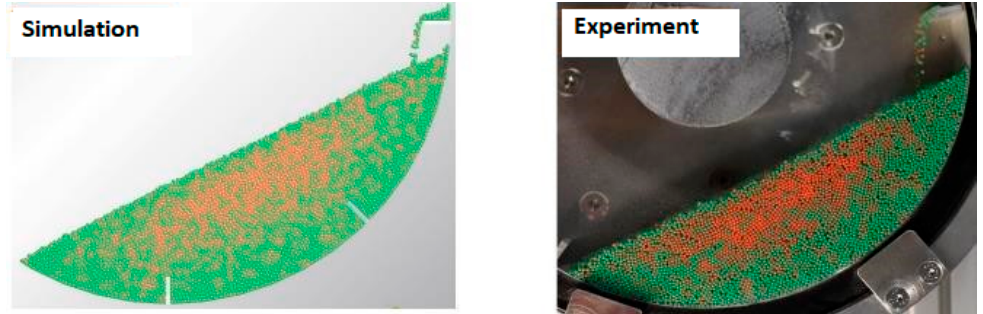
Figure 6. Simulated and experimental images of the front panel of the rotary drum showing the distribution of the beads in the first layer of the bi-density bed after 2 min (6 revolutions) of mixing. The drum is filled at 1/6 of its volume and equipped with 8 baffles of 1.5 cm height.